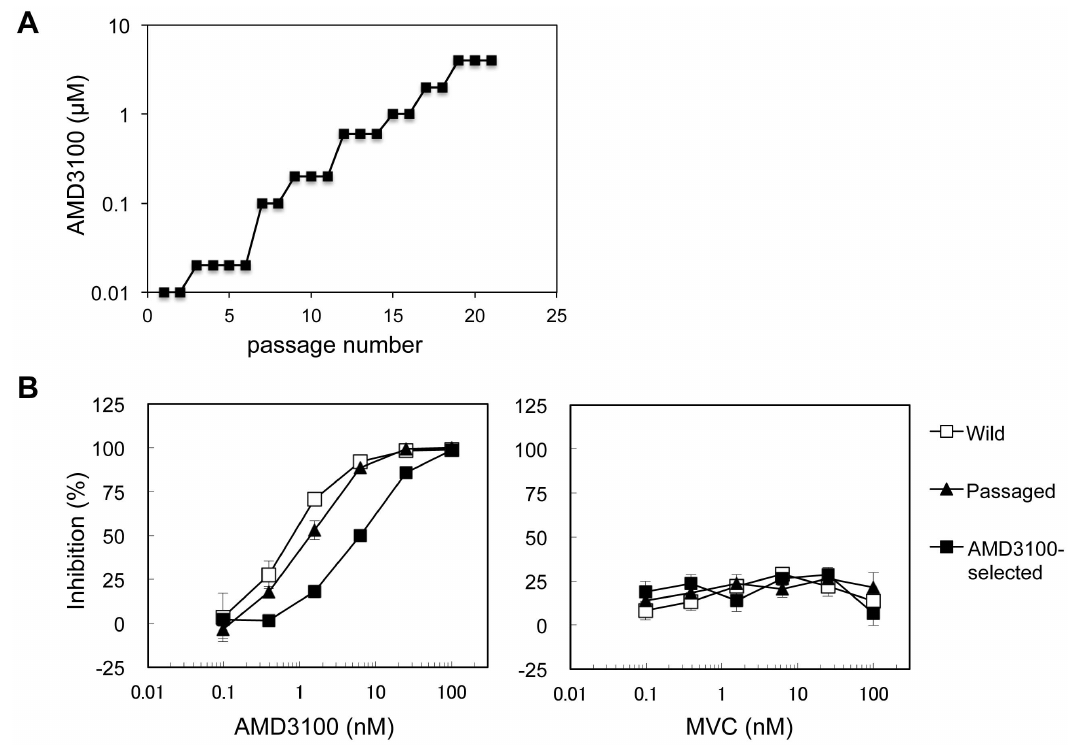
Figure 2. Selection of AMD3100-escape variants from HIV-1 JR-FLan/KI812.7 . (A) Induction of AMD3100-resistant variants from HIV-1 JR-FLan/ KI812.7 . Replication-competent HIV-1 JR-FLan/KI812.7 was passaged using SupT1/CCR5 cells in increasing concentrations of AMD3100 in the range of 20 nM to 4 m M. (B) Susceptibilities of AMD3100-selected variants to AMD3100 and MVC. TZM-bl cells were treated with various concentrations of AMD3100 or MVC, and infected with wild-type HIV-1 JR-FLan/KI812.7 , the virus passaged in the absence of AMD3100, or the selected virus in the presence of 4 m M AMD3100. Luciferase activities of TZM-bl cells were measured at 48 h post-infection. Data represent the extent of inhibition of replication relative to that in the absence of AMD3100 or MVC.